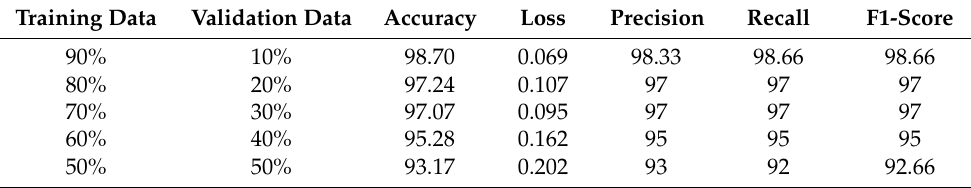
Table 7. The effect of reducing the training data on the performance of the optimized model. Training